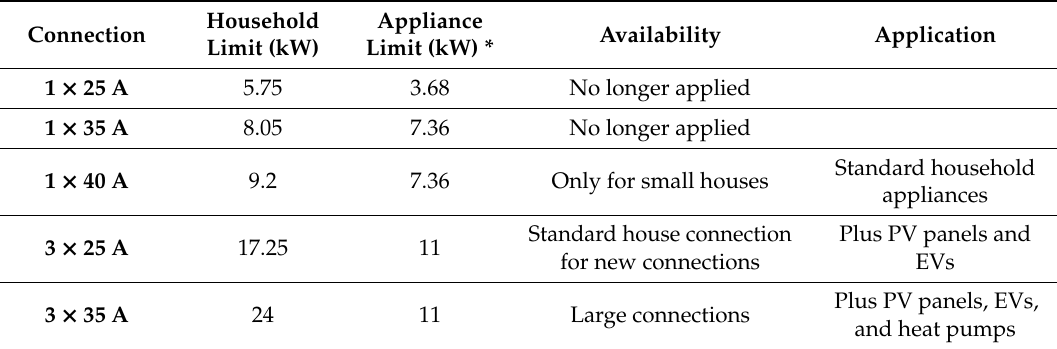
Table 2. Residential connections and their power limits